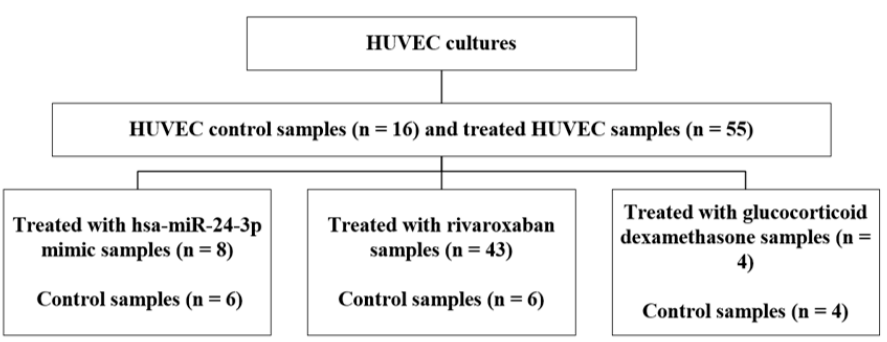
Figure 2. Number of samples used in gene expression assay.